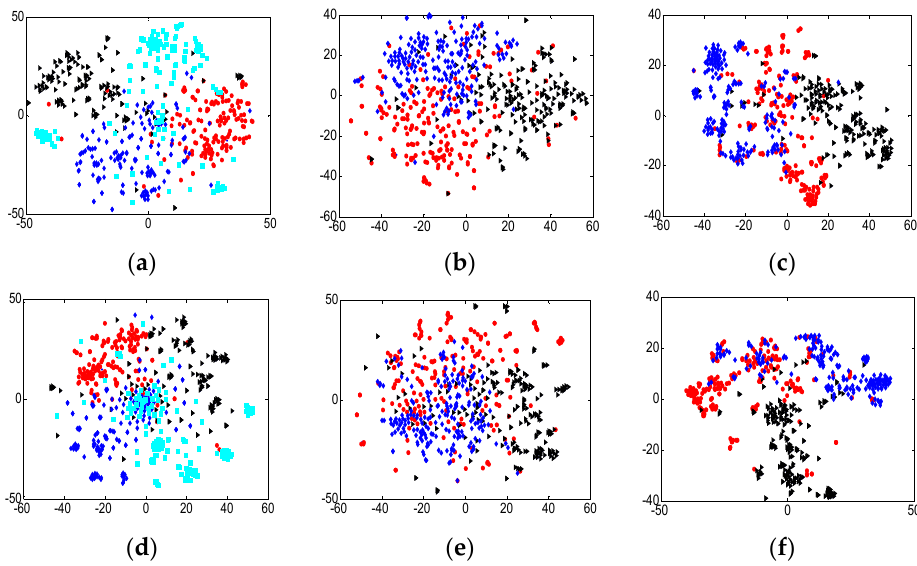
Figure 2. Visualization experiments. ( a – c ) The MRNR@1 ′ s visualization results on the Citeseer, DBLP, and SDBLP. ( d – f ) The MRNR@2 ′ s visualization results on the Citeseer, DBLP, and SDBLP.